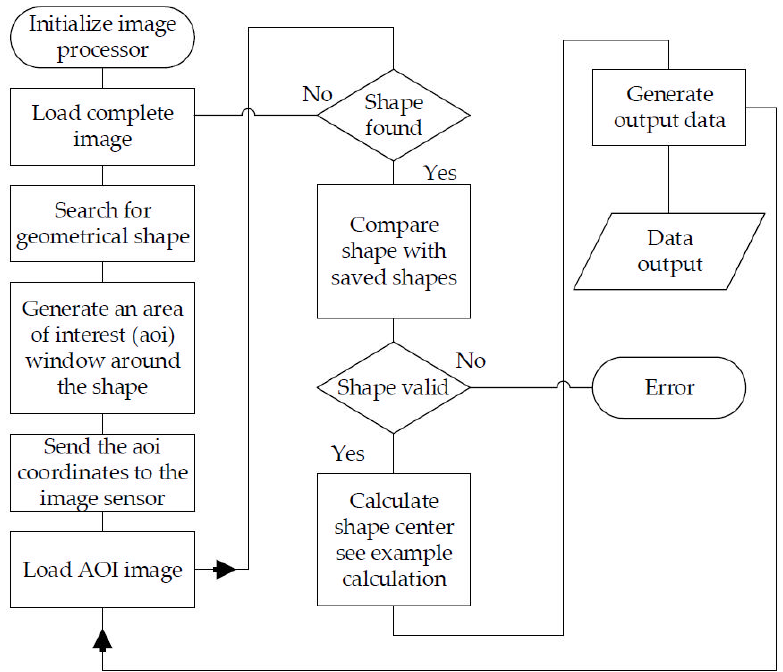
Figure 9. Schematic software procedure—normal use.